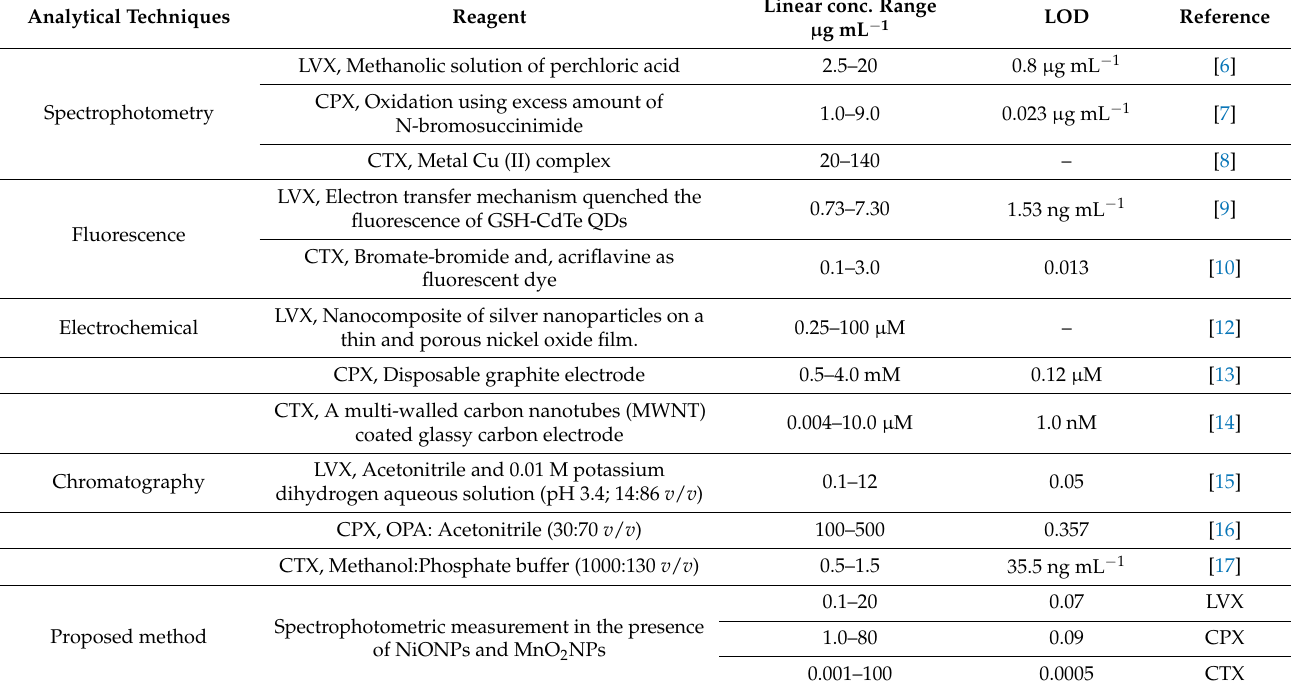
Table 7. A comparative study between the results obtained from the determination of LVX, CPX, and CTX using spectropho- tometry in the presence of NiONPs and MnO 2 NPs, respectively and the previously reported analytical techniques. Analytical